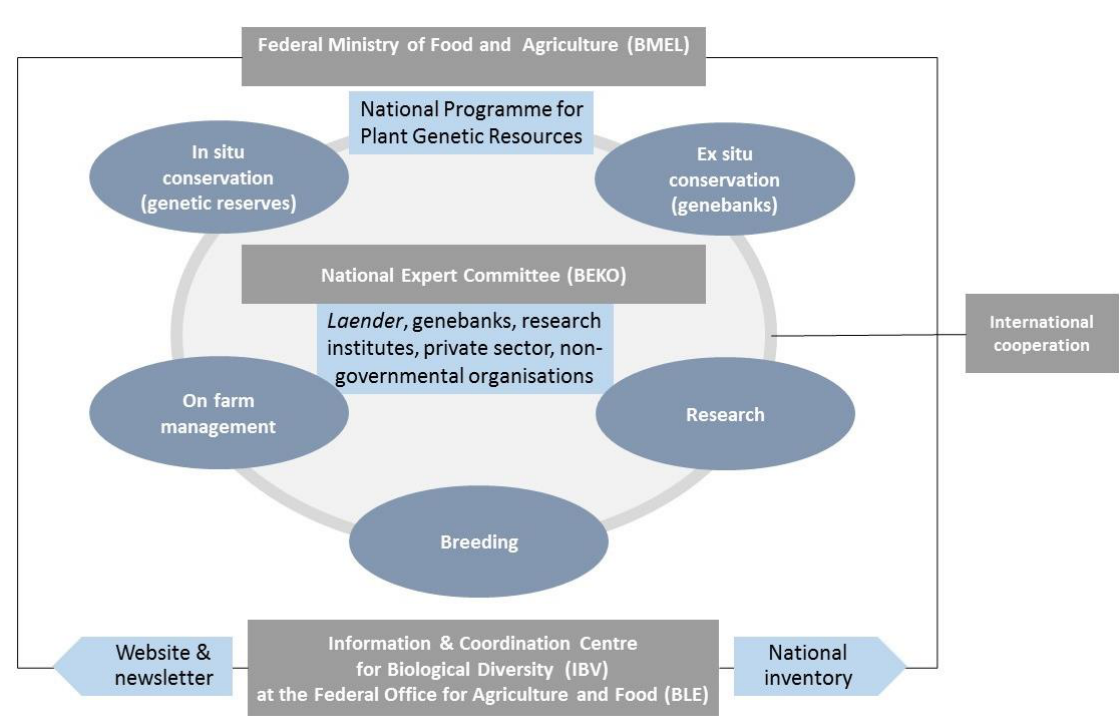
Figure 2. Elements of the German plant genetic resources system.